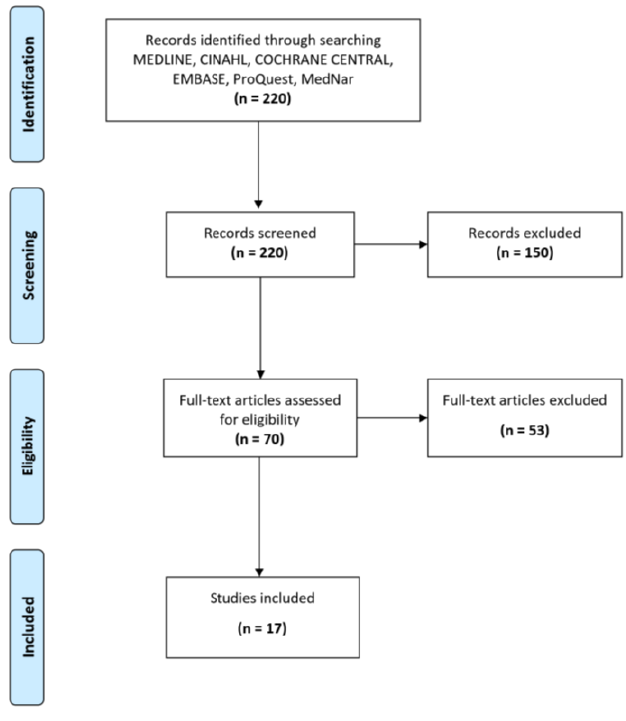
Figure 2. Flow diagram.